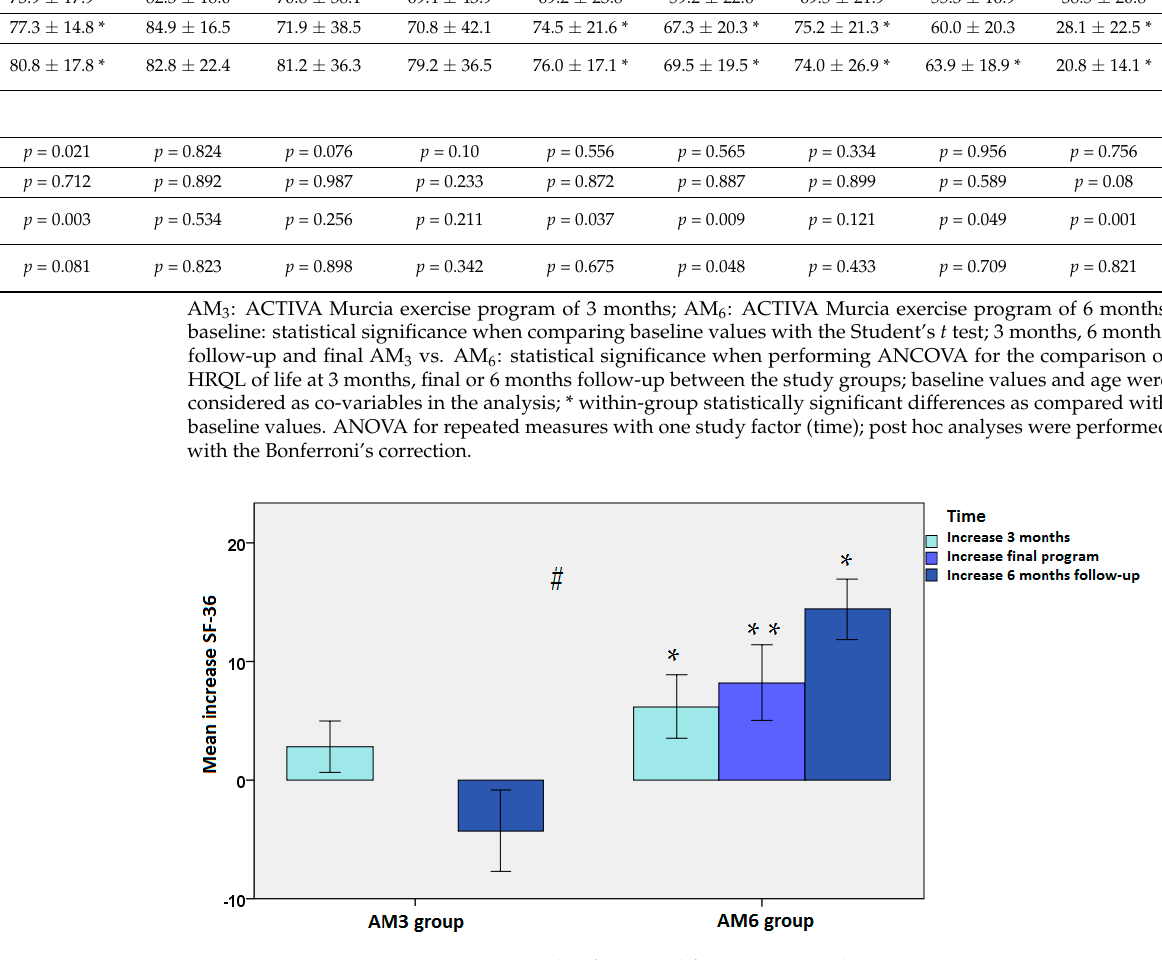
Figure 2. Mean changes in the subscale of physical functioning in the ACTIVA Murcia (AM) exercise programs of 3 months (AM 3 ) and 6 months (AM 6 ): * p < 0.05 and ** p < 0.001 as compared with baseline using ANOVA for repeated measures with one study factor (time); post hoc analyses were performed with the Bonferroni’s correction; # p < 0.003 at 6 months of follow-up of the AM 3 vs. AM 6 using ANCOVA: dependent variable (physical functioning at 6 months follow-up); fixer factors (program and sex); covariates (baseline values and age).